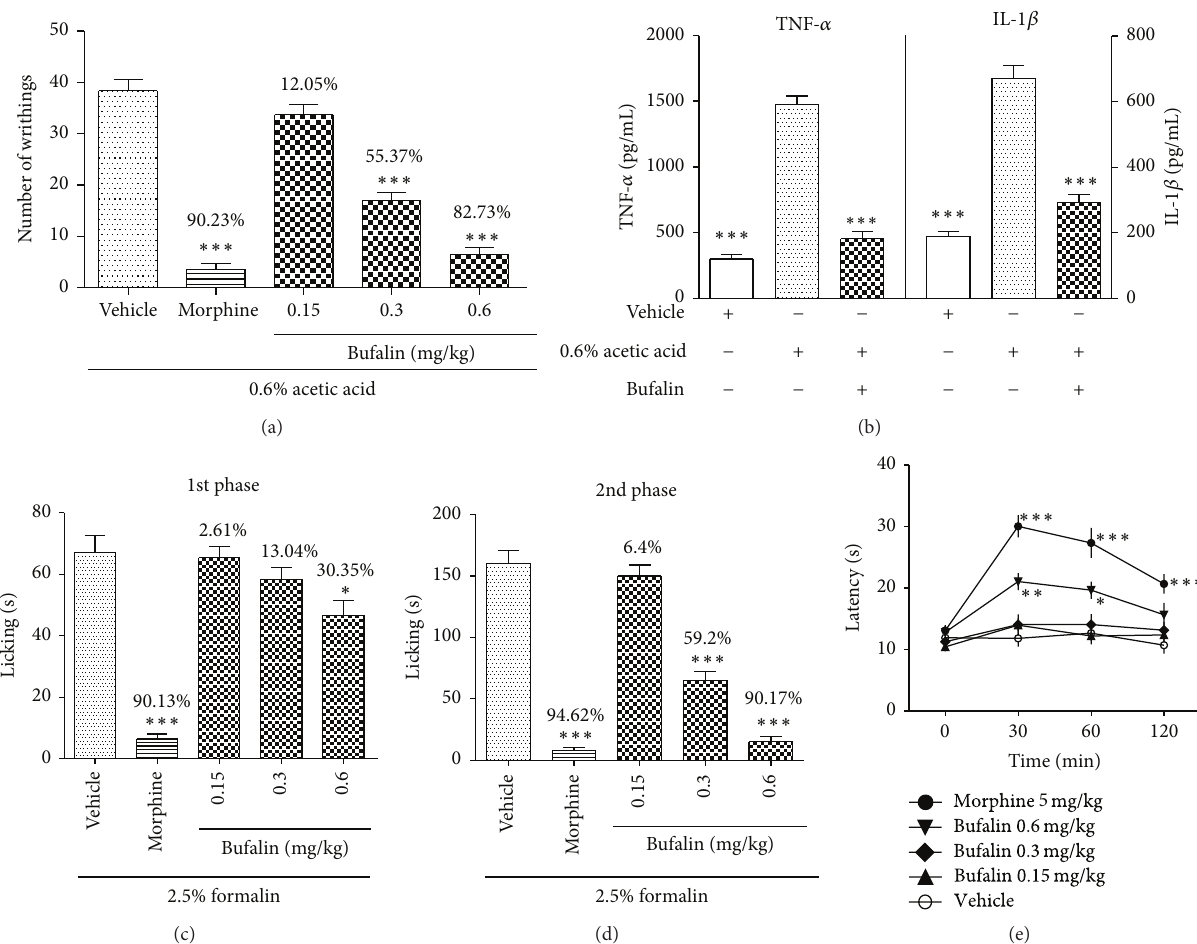
Figure 4: The antinociceptive effect of bufalin. (a) Bufalin (0.15, 0.3, or 0.6 mg/kg), the reference drug morphine (5mg/kg), and the vehicle wereadministeredtomice30minbeforeaperitonealinjectionofaceticacid.Thenumbersofabdominalwritheswererecorded.Theinhibition rate of the writhes for 20min following acetic acid injection was calculated ( 𝑛 = 8 ). (b) ELISA was used to test TNF- 𝛼 and IL-1 𝛽 produced by peritoneal cells harvested from peritoneal cavity of animals that underwent acetic acid-induced writhing tests ( 𝑛 = 5 ). Effects of bufalin and morphine on the licking time of the formalin test in mice during the first (0–5min) (c) and second phases (15–30min) (d) ( 𝑛 = 8 ). (e) The hot plate latency was measured at 0, 30, 60, and 120 min after administration of bufalin, morphine, or vehicle ( 𝑛 = 8 ). Data are expressed as the mean ± S.E.M., ∗ P < 0.05, ∗∗ P < 0.01, and ∗∗∗ P < 0.001, compared with the vehicle